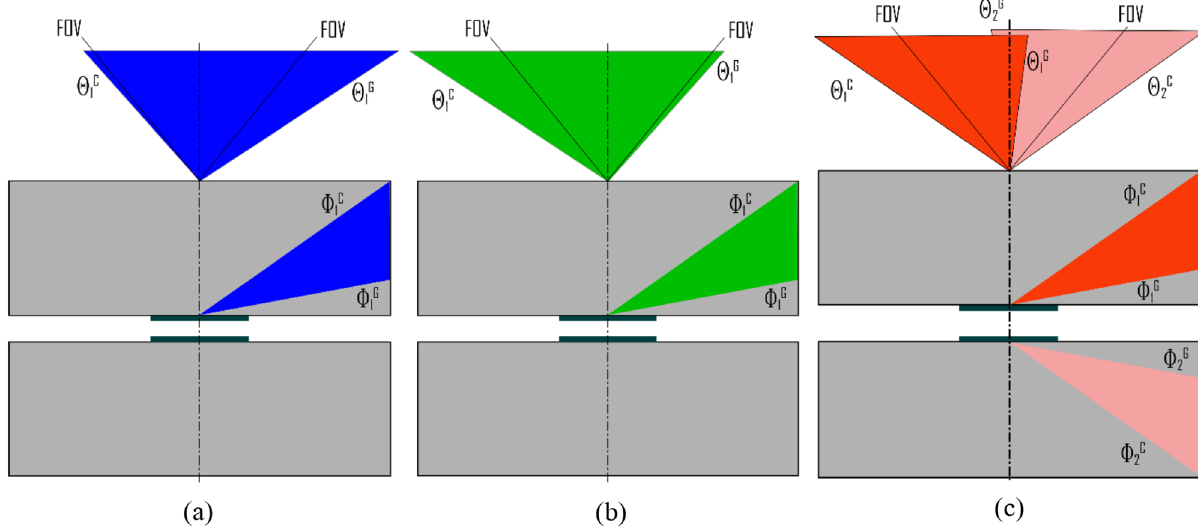
Fig. 7. Schematic side view of a single waveguide system with symmetrical fi eld of view for three different colors: (a) blue, (b) green, (c)